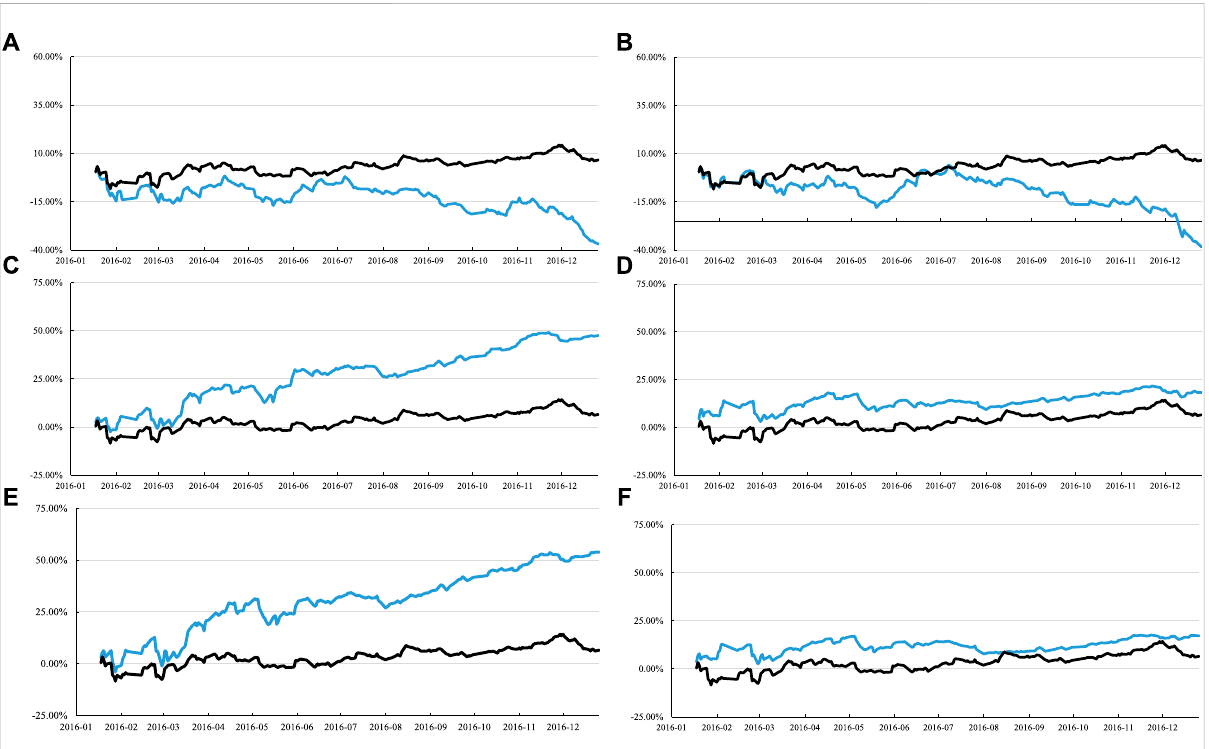
FIGURE 7 Six sub fi gures are shown. In each sub fi gure, the horizontal axis represents the data time from January 2016 to January, 2017, and the vertical axisrepresentsthereturnoftheportfolio.TheblacklinerepresentstheperformanceofHS300asabenchmarkineachsub fi gure.Thebluelinesshow theperformance ofdifferentportfolio strategies. (A) Constructing thereturnofthe portfolio strategy byclustering results combined with the Sharpe ratio, − 41%, which is extremely lower than the benchmark. (B) Portfolio strategy only constructed by the Sharpe ratio and the return is 39.4%, which is also lower than the benchmark. Other four portfolios perform better than the benchmark, clearly. It is noticed that the annual return percentages of the portfolio are 52.6%, 20%, 59.7%, and 18.7%. The strategy in (C) is the return of the portfolio with clustering results combined with the small market value. The strategy in (D) is the return of the portfolio constructed by the small market value. In (E) , it takes an assumption that 30 chosen stocks as a portfolio of clustering results combine with a small market value and show the return of the portfolio. In (F) , the return of the portfolio is constructed only by the small market